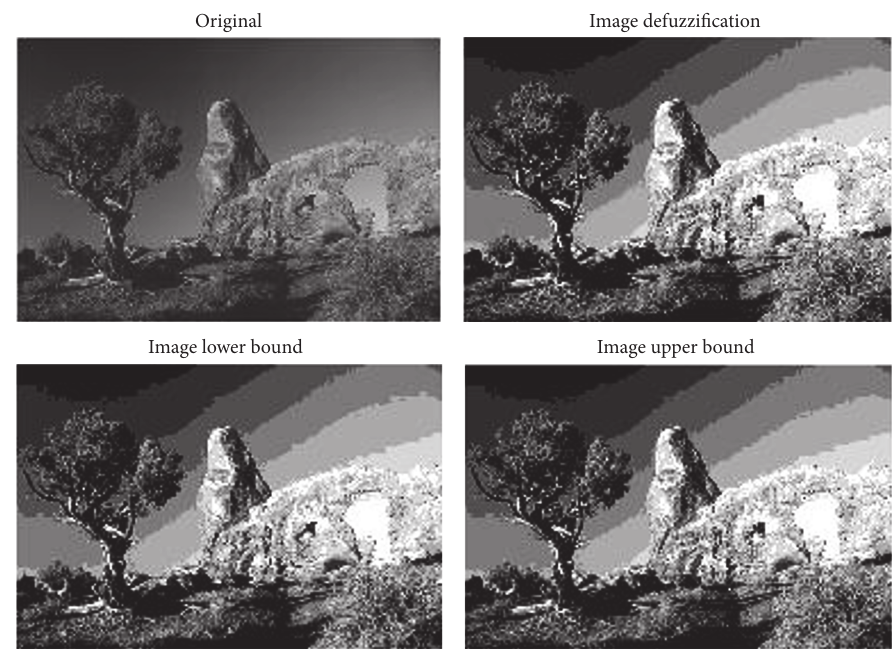
Figure 6: The resulting image clustering performed by the IT2FPCM algorithm for 7 clusters to Figure 2(d) because of the gray levels containing the image. Table 42: Results of the IT2PE validation index to the clustering of image shown in Figure 2(e) using IT2FPCM and IT2FCM algorithm with 𝑚 = [1.5, 2.5] and 𝜂 = [1.5, 2.5] as